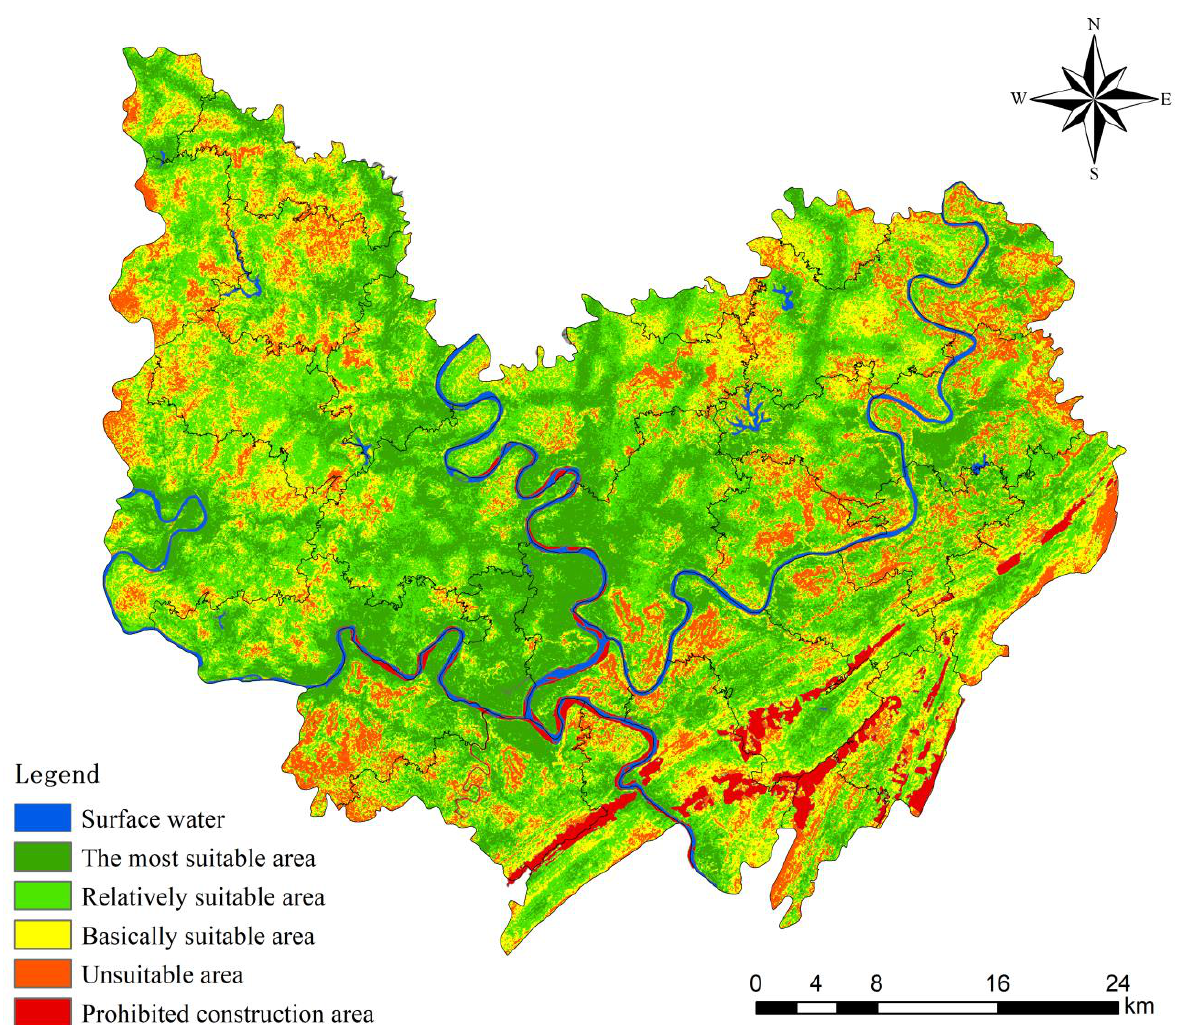
Figure 6. Suitability evaluation map of construction land in Hechuan District.